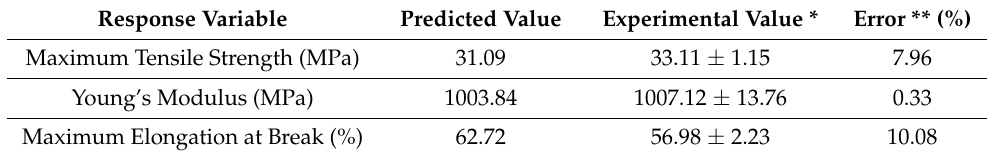
Table 5. Experimental validation of mechanical properties at the optimal conditions for the films.